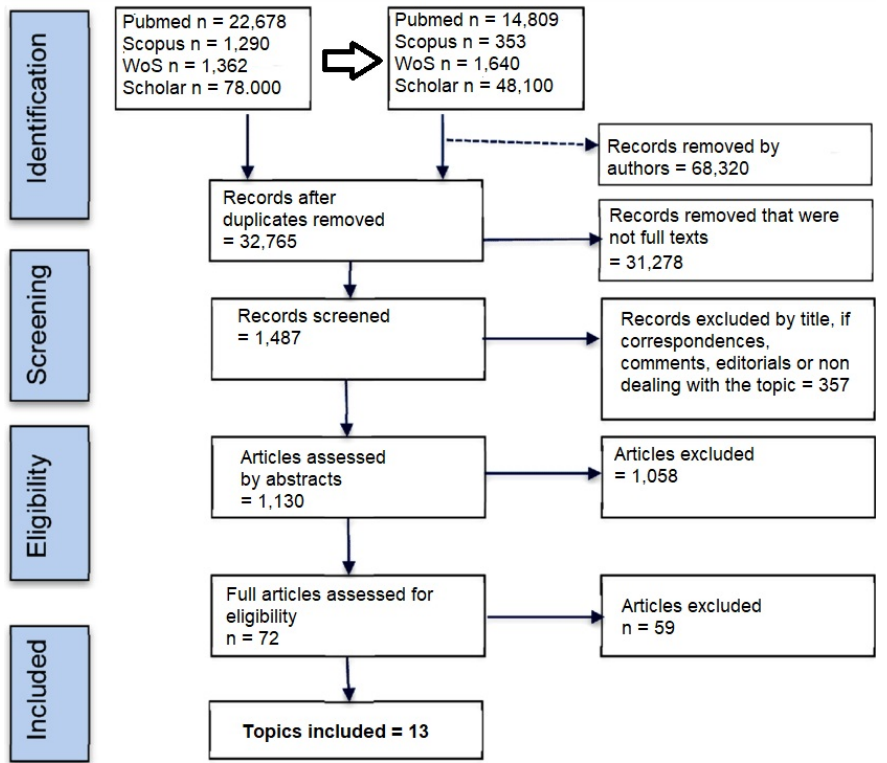
Figure 4. PRISMA Flow diagram of literature selection.